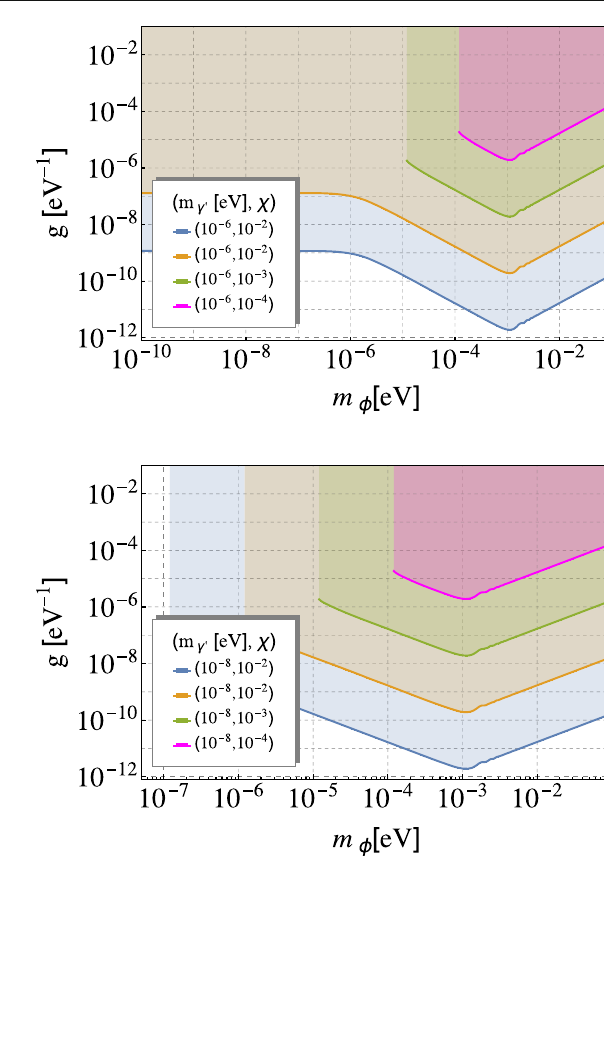
horizontal lines. The plots confirm that, in the weak mixing regime (under the dashed line), the oscillations start to dom- inate the probability when m 2 φ L /( 4 ω) > 1 and the expected the sensitivity to the ALP gets